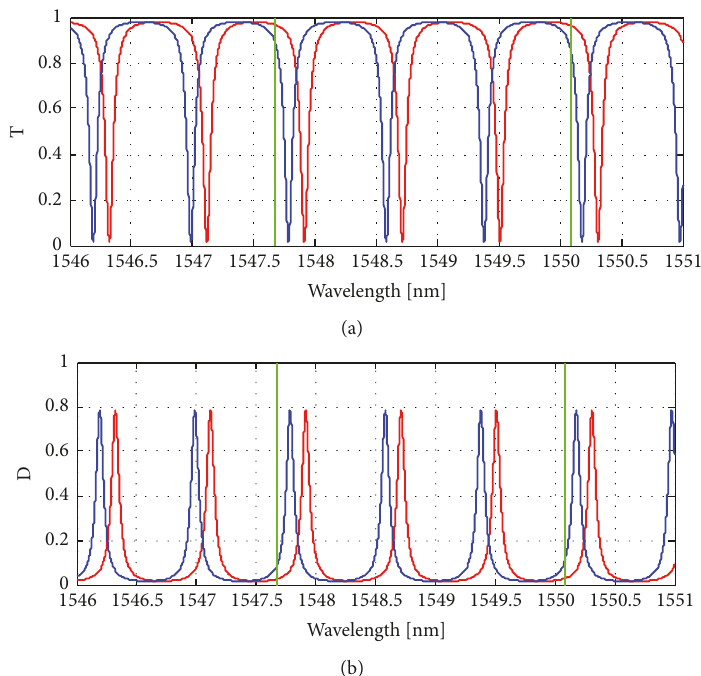
Figure 8: Transfer function: (a) at the through port; (b) at the drop port (P traffic = 24.5 dB).